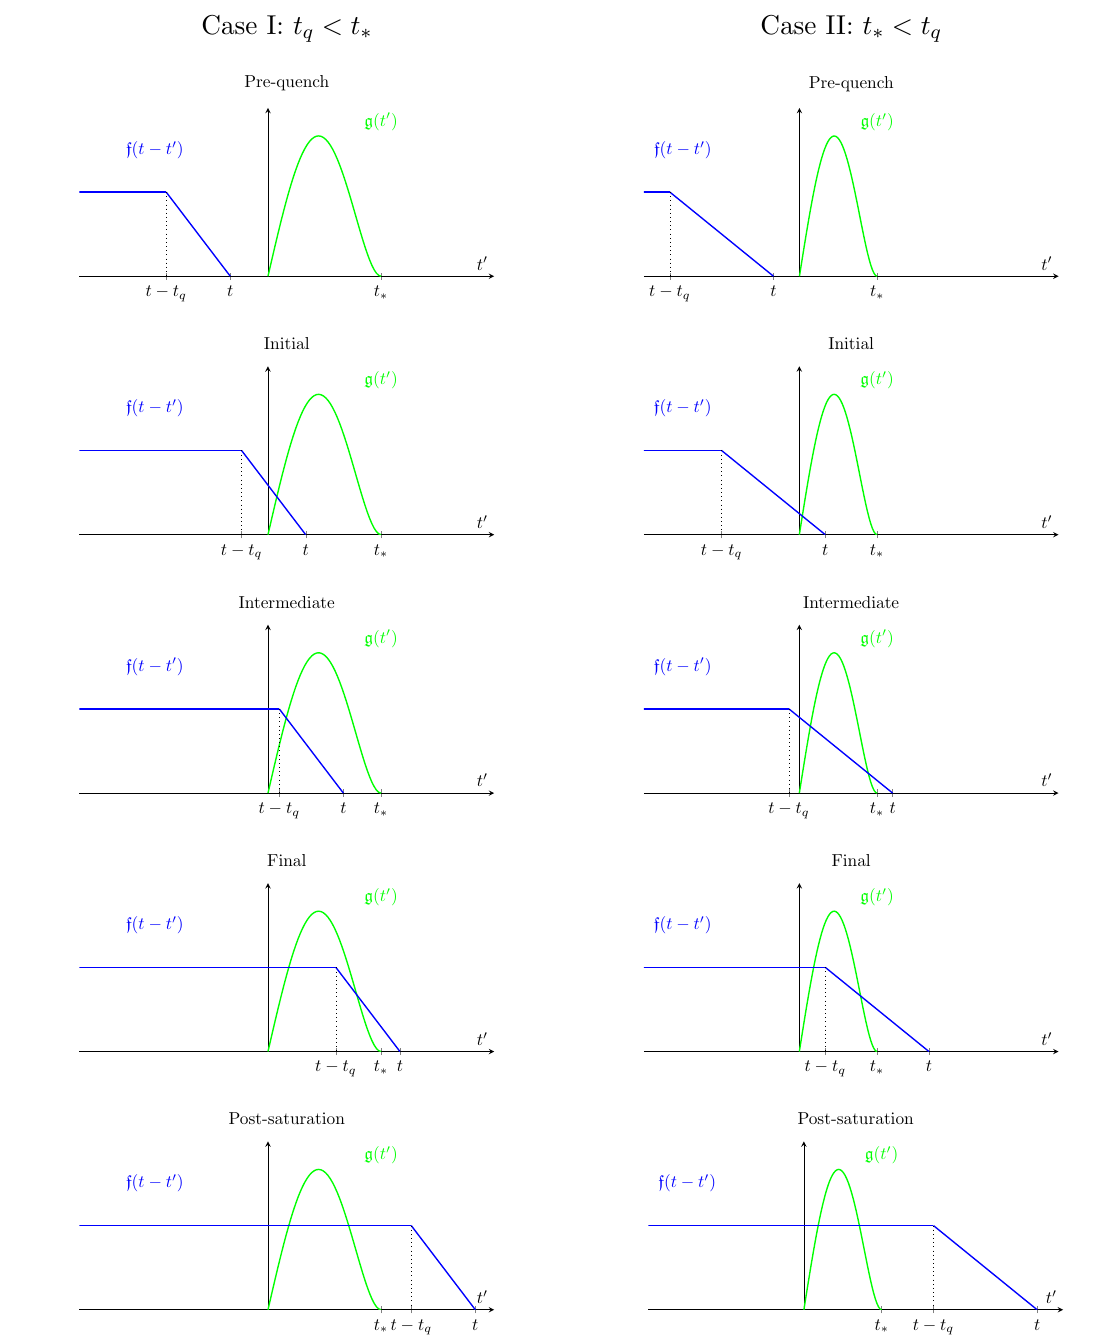
and II: t < t q , respectively. In (cid:3) (cid:3)